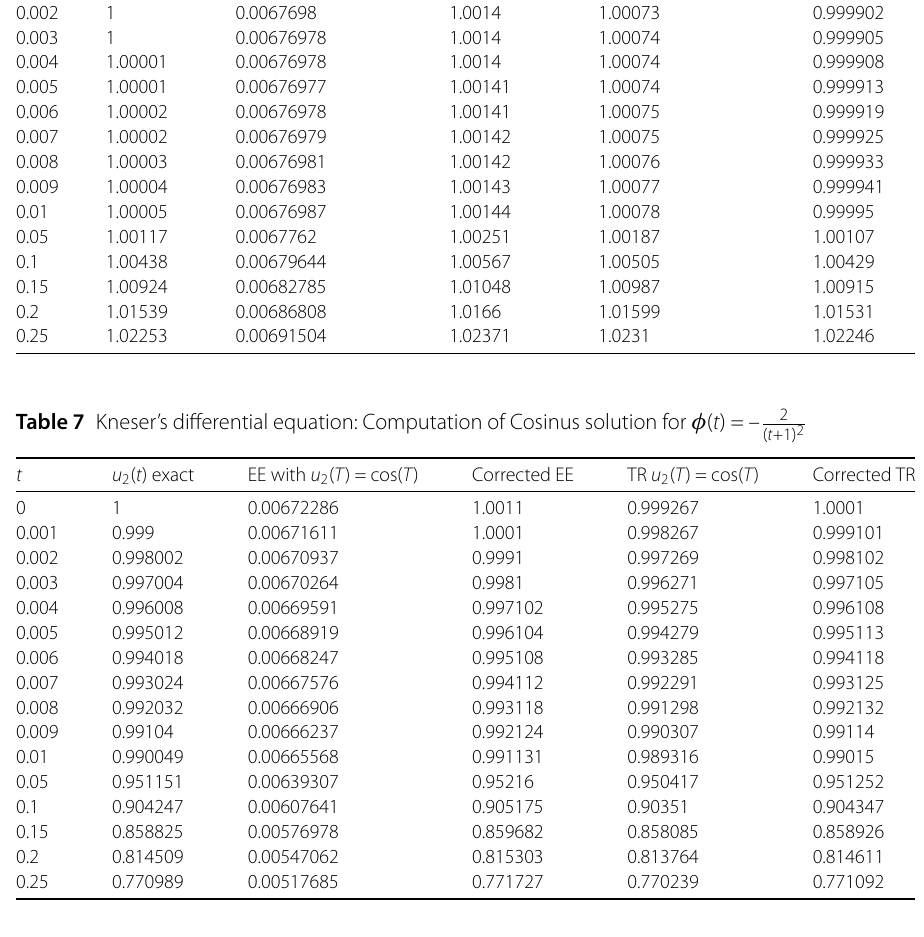
Table 6 Kneser’s differential equation: Computation of Sinus solution for φ ( t ) = – 2